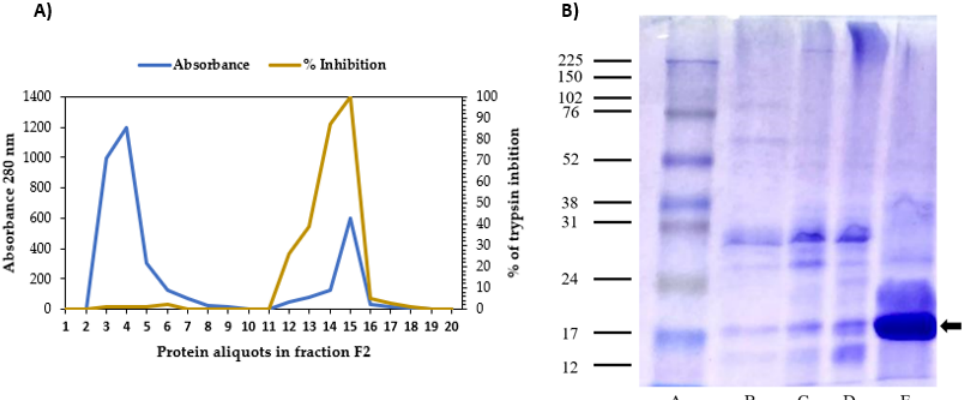
Figure 1. ( A ) Isolation of trypsin inhibitor from tamarind seeds. A. Chromatographic profile and antitrypsin activity of protein fraction 2 of tamarind seeds by CNBr 4B Trypsin-Sepharose Affinity Chromatography. The blue line represents aliquots of proteins monitored at 280 nm by spectropho- tometry, the first peak being the elution of unretained material, and the second peak, the proteins adsorbed on the matrix eluted with HCl (5 mM). The brown line represents the antitrypsin activity, using 100 μ L of TTI and 1.25 mM BApNA (Nbenzoyl-dl-arginine-p-nitroanilide) as substrate. ( B ) This shows 12.5% denaturing polyacrylamide gel electrophoresis (SDS-PAGE) stained with Coomassie blue R-250. A. Molecular Weight Marker Amersham™ ECL™ Rainbow™ Marker—Full range GE Healthcare; B. Crude Extract; C. Protein fraction 1 (saturation using 0–30% ammonium sulfate); D. Protein fraction 2 (saturation with 30–60% ammonium sulfate); E. TTI (tamarind trypsin inhibitor) (arrow).